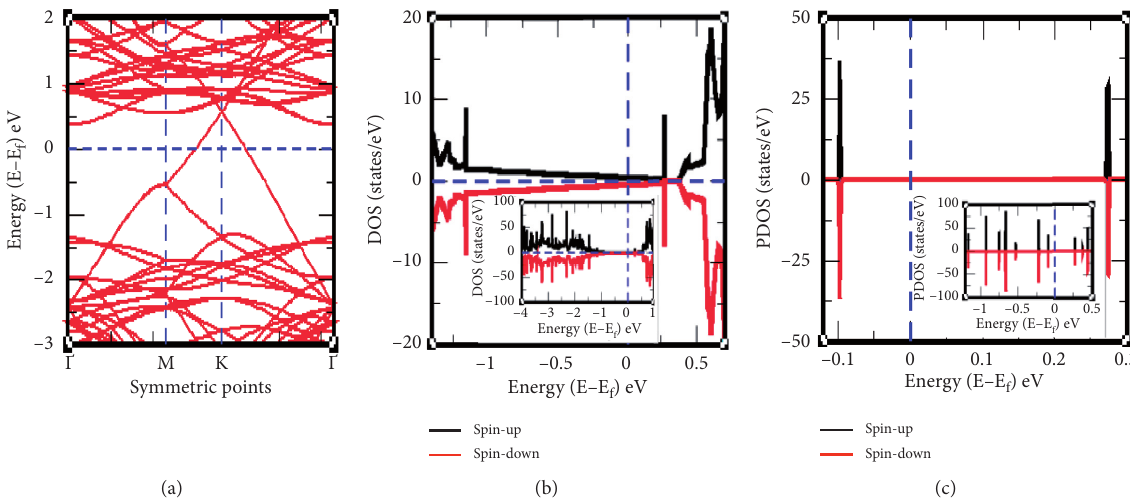
Figure 3: (a) Band structure of HS-G/MoS 2, where horizontal dotted line represents the Fermi level. (b) Spin-up and spin-down electrons are symmetrically distributed in the DOS plot of HS-G/MoS 2 . (c) Spin-up and spin-down electrons are symmetrically distributed in the PDOS plot of HS-G/MoS 2 . In all DOS and PDOS plots, the vertical dotted line represents the Fermi level. States above the horizontal dotted line represent spin-up electrons and states below the horizontal dotted line represents spin-down